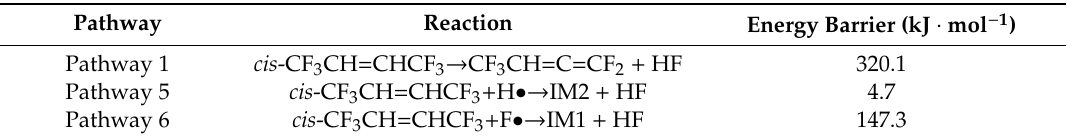
Table 2. Typical pathways of hydrogen fluoride (HF) formation and energy barrier.